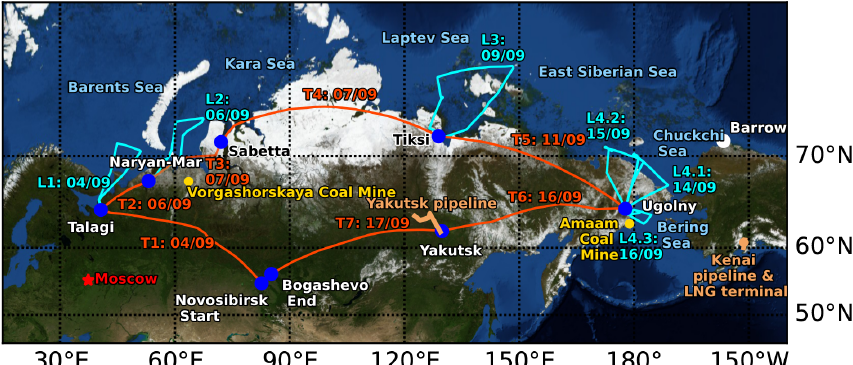
Figure 1. September 2020 campaign flight plan. The 13 flights are indicated as either “loop” (prefix L, cyan line) or “transit” (prefix T, orange line). Oil and gas (O&G) infrastructures and coal mines are shown in light orange and yellow respectively (Global Coal Mine Tracker, 2022; Global Fossil Infrastructure Tracker, 2022), the data are under the Creative Commons License, https://globalenergymonitor. org/creative-commons-public-license/ (last access: 19 September 2021). Map background: “Blue Marble Next Generation”, September 2004 (Stöckli et al., 2005).